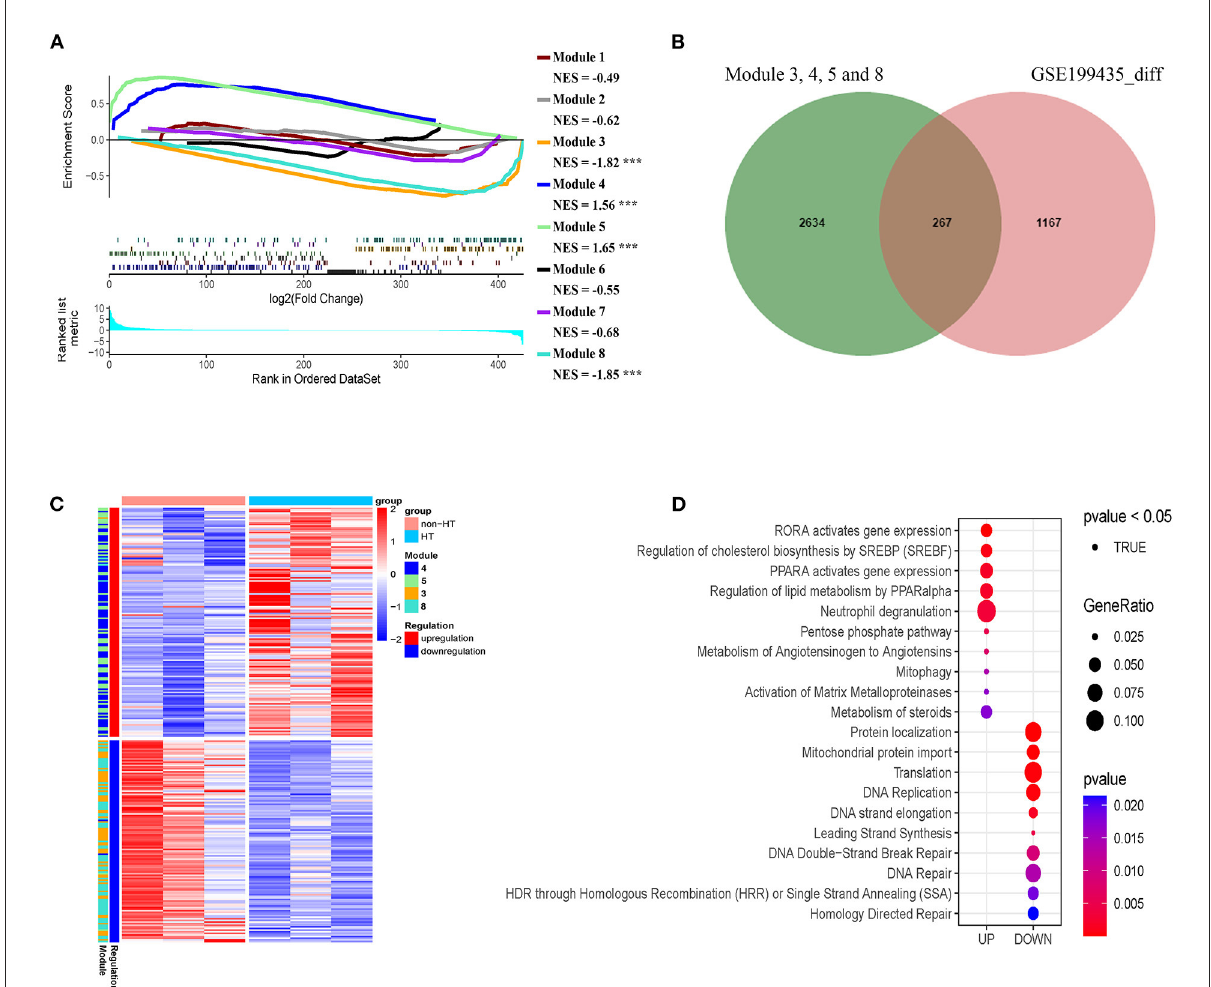
FIGURE11 Genes in modules in subgroup I overlaps with hemorrhage transformation (HT)-specific differentially expressed genes (DEG). (A) Pre-ranked gene set enrichment analysis showing the enrichment of DEG related to HT in the co-expression modules with subgroup I-specific signature genes. (B) Venn diagram showing the number of overlapped genes (267) between HT-specific DEG and subgroup I-specific genes. (C) Heatmap representing the overlap genes between DEGs related to HT and subgroup I-specific genes. (D) Diagram showing pathways identified by Reactome with the negative log 10 p -values of the overlapped genes shown in B and